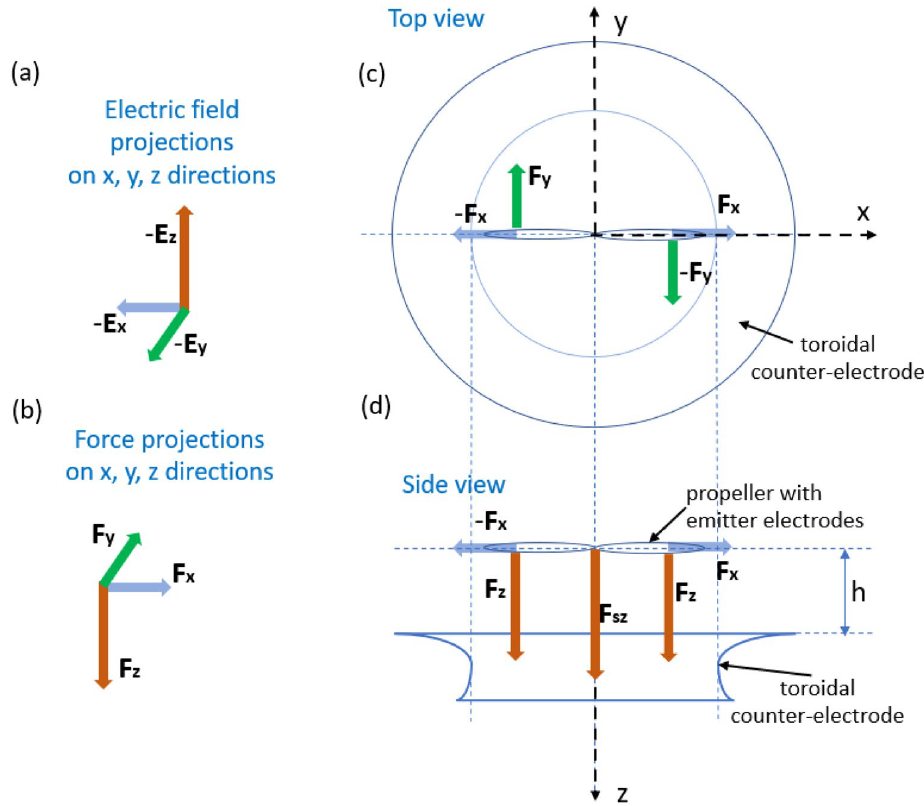
Figure 2. Axial thrust generation in a RIE with toroidal counter electrode. ( a ) Electric field projections at the emitter electrodes ( b ) Force acting on the ions projections at the emitter electrodes. ( c ) Top view of the RIE system. The propeller is coaxial to the toroidal counter electrode. ( d ) Side view of the